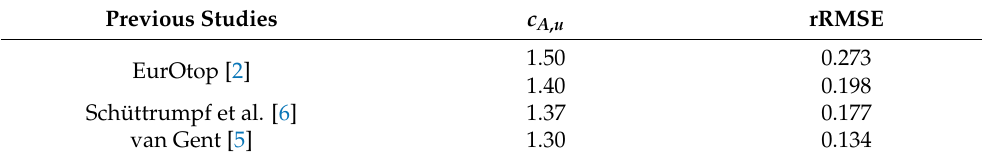
Table 3. Quantitative results on the estimation of OFV using different empirical coefficients available in the previous